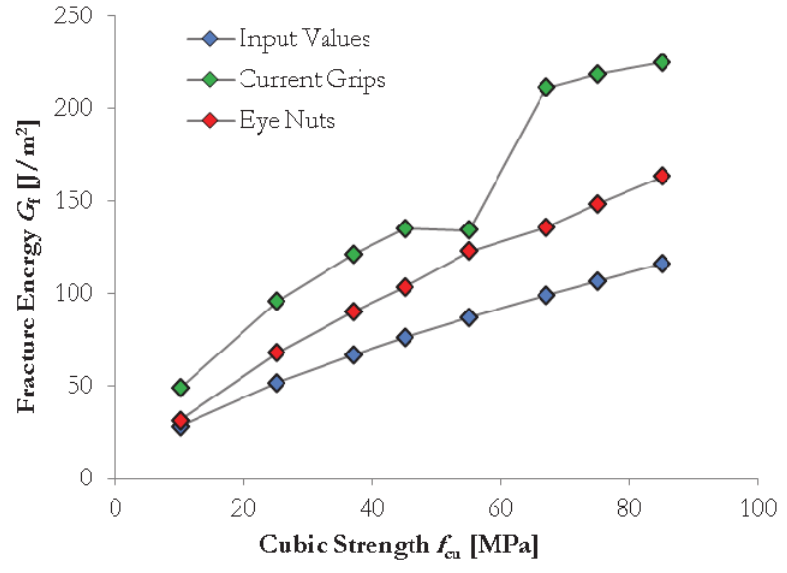
Figure 7: Fracture energy – input values and those obtained from numerical results.